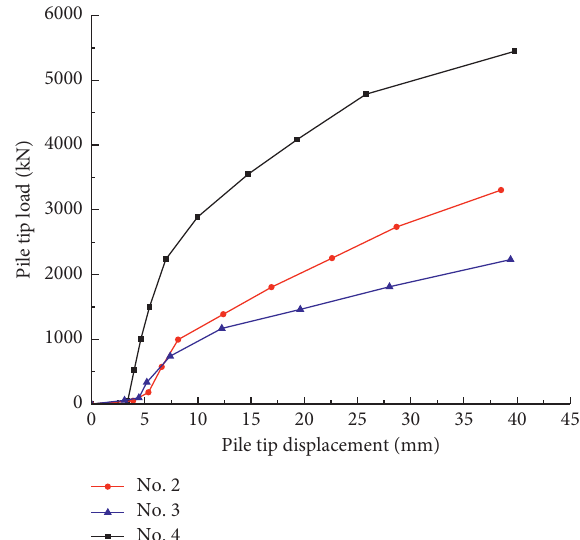
Figure 15: Relationship curve between pile tip resistance and pile tip displacement. (a) No.1 pile. (b) No. 2 pile. (c) No. 3 pile. (d) No. 4